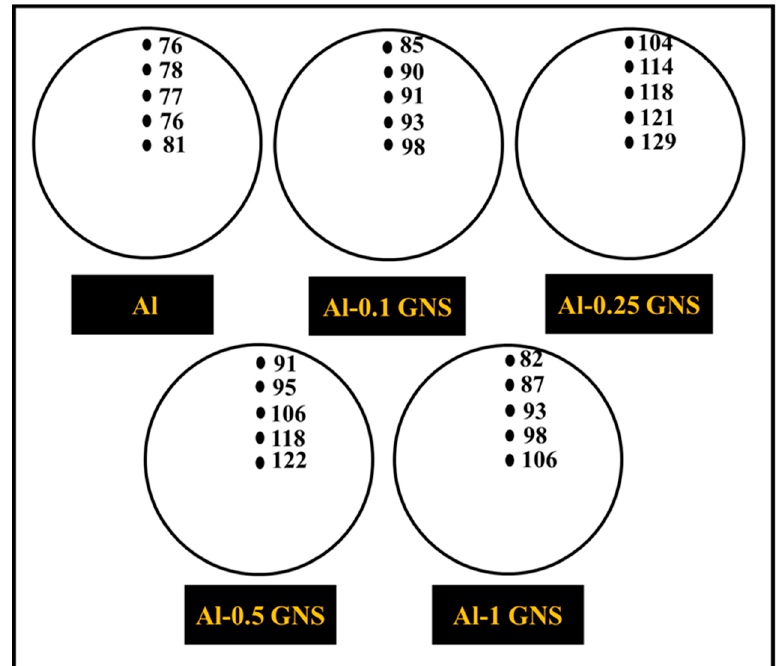
Figure 8. Variation of microhardness (HV) from the center to the edge of samples with different GNS content (Samples were prepared from the top part of the consolidated billet).